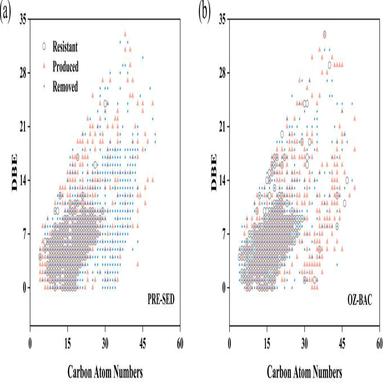
DBE of DOM in drinking water treatments including pre-ozonation and coagulation-sedimentation, and ozonation-BAC.